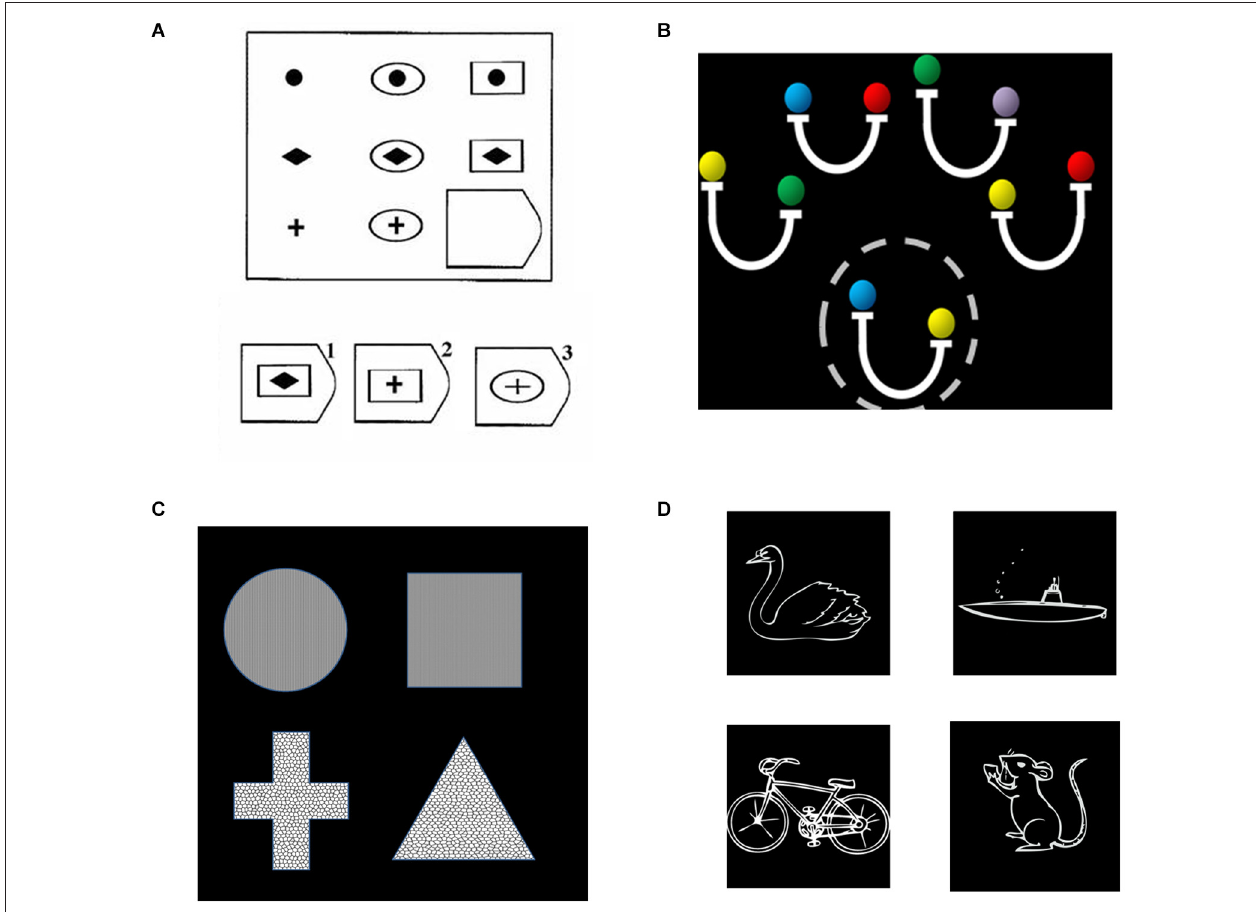
task, equivalent stimuli were used across conditions. The given stimulus is a texture match, because the top two shapes share the same texture, a shape mismatch, because neither pair share the same shape, and a relational match, because the same dimension of match (texture) is present for both the top and bottom pairs. (D) The semantic picture matching task follows the same logic as the relational matching task, but utilized animal vs. vehicle and land vs. water as dimensions of possible match or mismatch. The example depicts a relational match, in that the dimension of match for the top pair (land vs. water) is the same as the dimension of match for the bottom